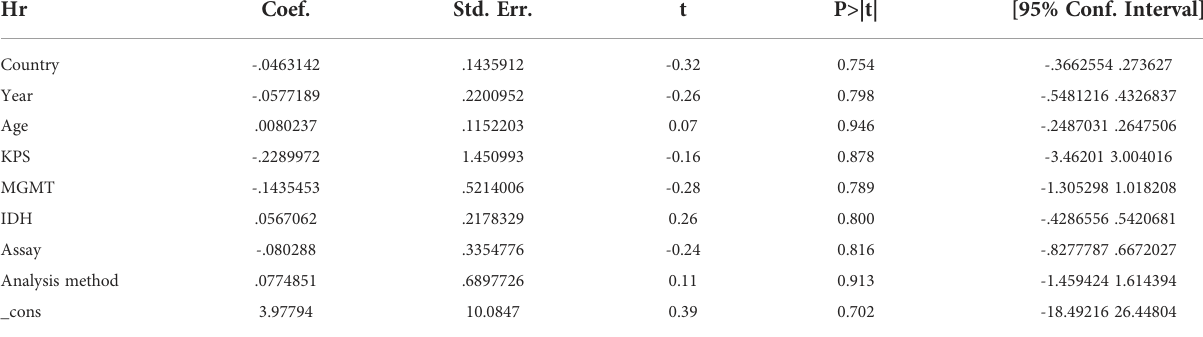
TABLE 2 Meta-regression.